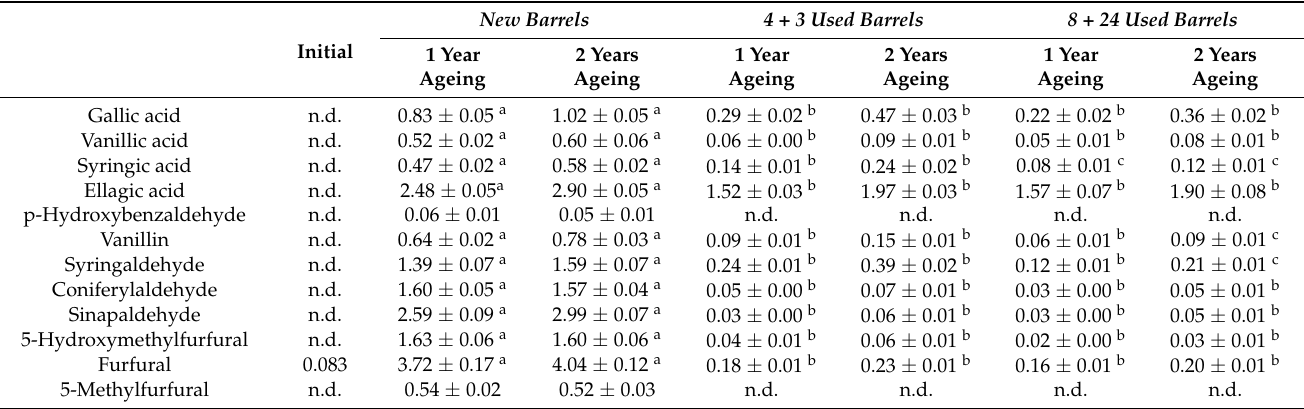
Table 5. Phenolic compounds content (mg/100 mL of 100% vol. alcohol) in brandies aged in New barrels , 4 + 3 Used barrels , and 8 + 24 Used barrels after the first and the second year of ageing.